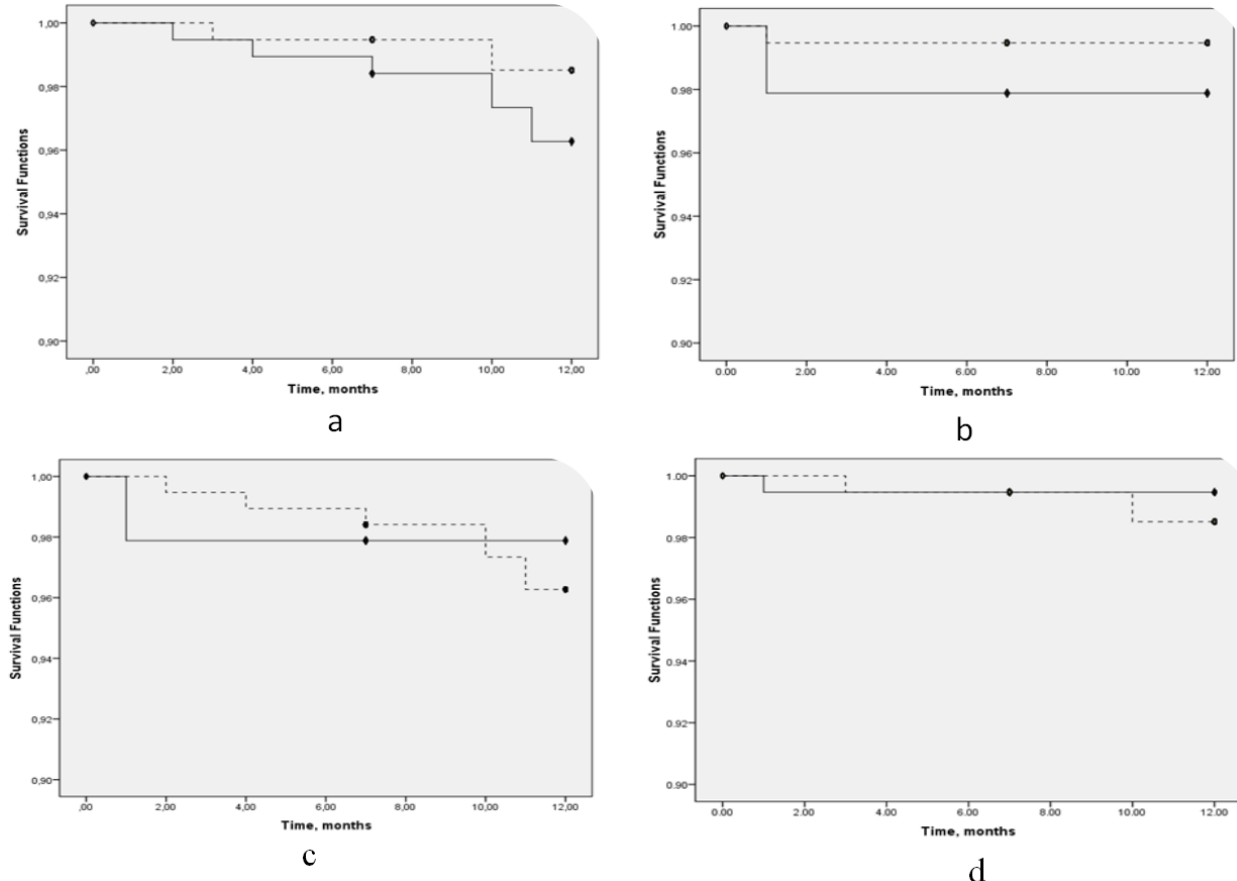
Figure 2. Kaplan–Meier survival distribution functions for (a) electronic ear tags placed on the mid-point (straight line) and the first-quarter part (dotted line) of the ear, for (b) visual ear tags placed on the mid-point (straight line) and the first-quarter part (dotted line) of the ear, for (c) electronic (dotted line) and visual ear tags (straight line) placed on the mid-point part (1 / 2) of the ear, and for (d) electronic (dotted line) and visual ear tags (straight line) placed on the first-quarter part (1 / 3) of the ear in